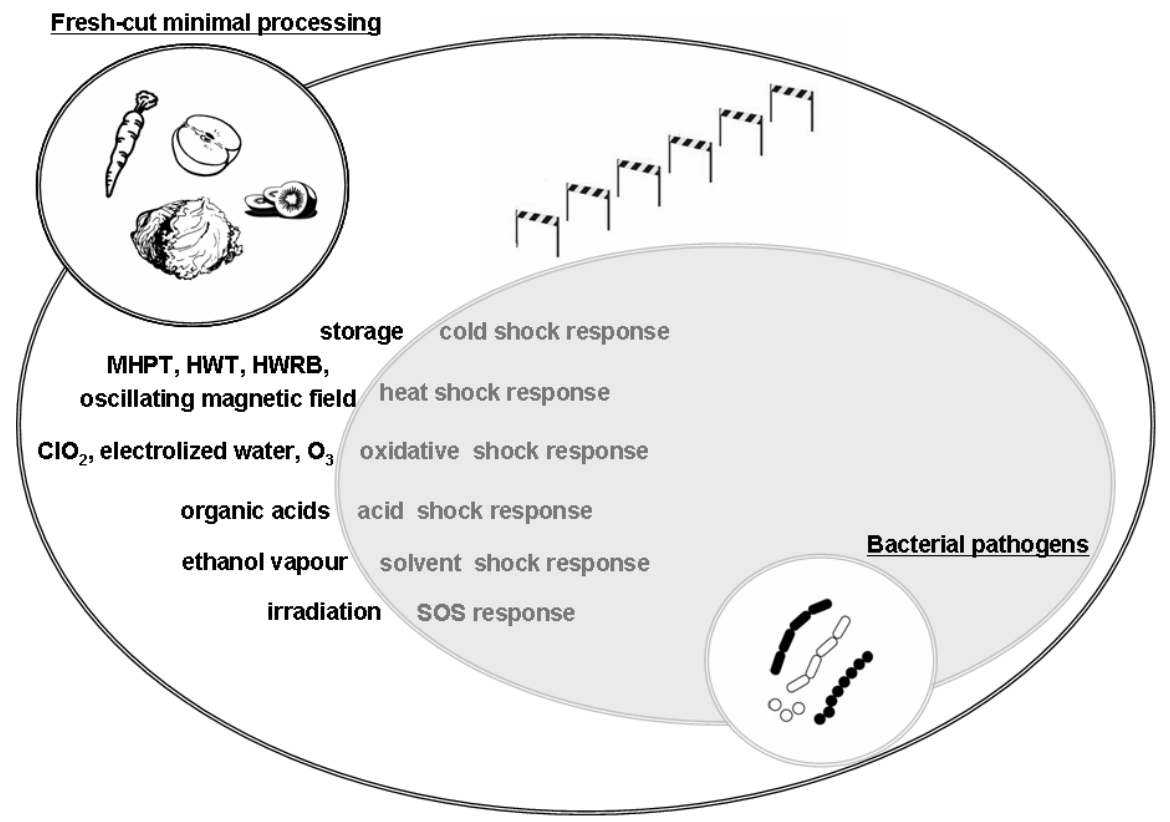
Figure 2. Exemplificative interdependent factors that influence pathogens survival and growth on fresh-cut minimal processing [mild heat pre-treatments (MHPT); hot water immersion treatment (HWT); hot water rinsing and brushing (HWRB); oscillating magnetic fields (ohmic heating, dielectric heating, microwaves)]. Combined effects of several antimicrobial strategies is known as “hurdle